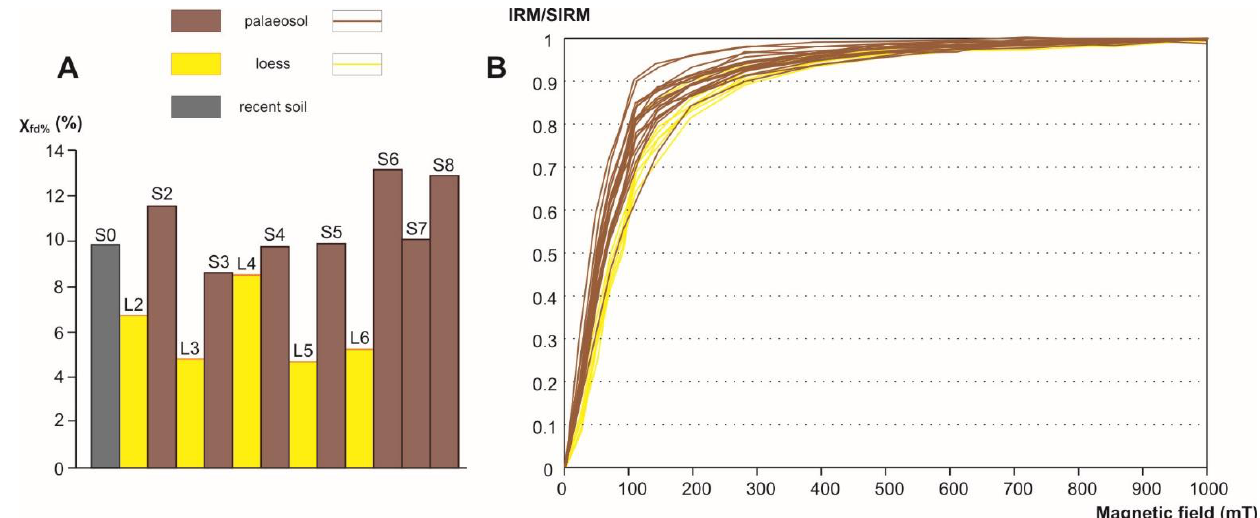
Figure 4. ( A ) Mean χ fd% values for each palaeosol and loess unit of the Dolynske section and ( B ) examples of isothermal remanent magnetisation acquisition curves of typical palaeosol and loess samples.